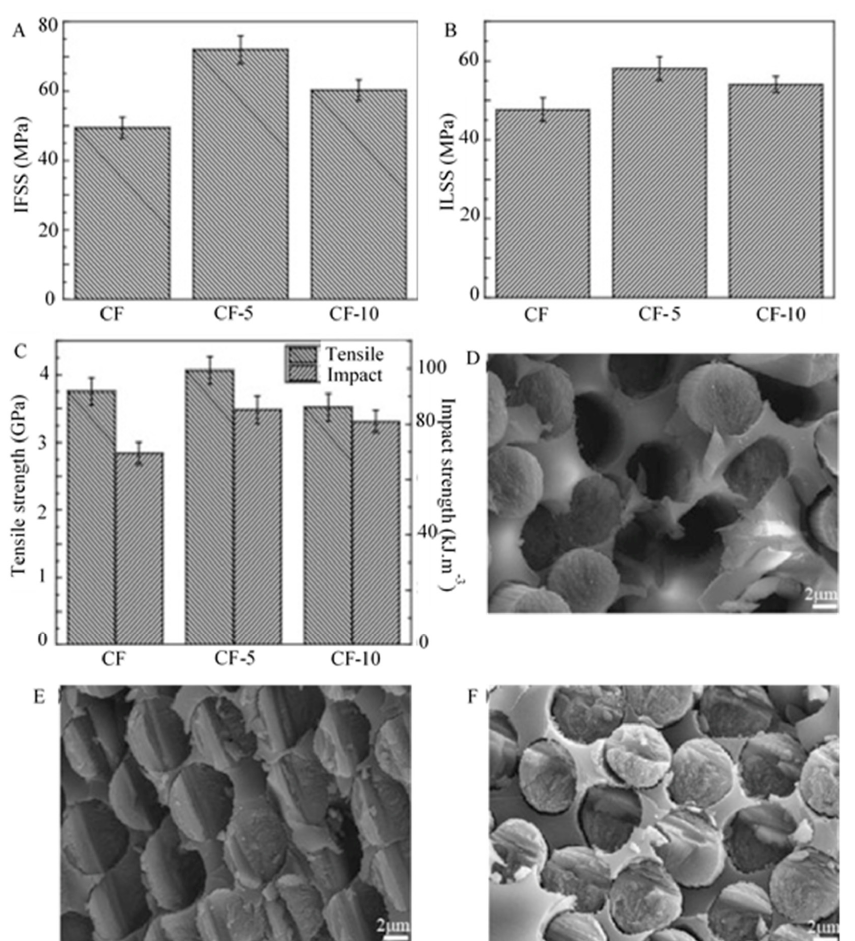
Figure 3. Mechanical properties of carbon black coated CFs/epoxy composites: ( A ) IFSS tests results of the composites. ( B ) ILSS of the composites. ( C ) Impact test results of the composites and single fibre tensile strength. SEM morphologies of the fracture surface of composites ( D ) the untreated-CF, ( E ) CF-5 min, ( F ) CF-10 min. Reprinted with permission from ref. [22], Copyright 2017 Elsevier Ltd.